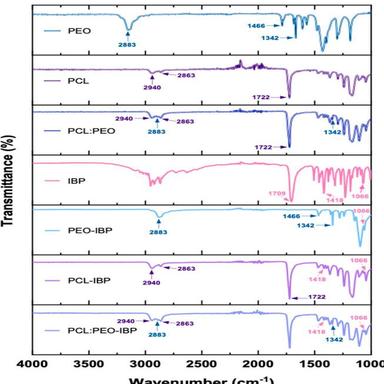
FTIR spectra of PEO, PCL, PCL:PEO, IBP and IBP loaded singular/binary fibers.